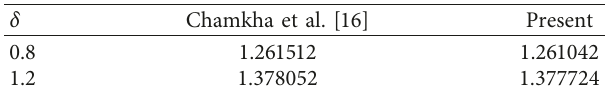
Table 3: Comparison of heat transfer rate − θ ′ ( 0 ) when M � f